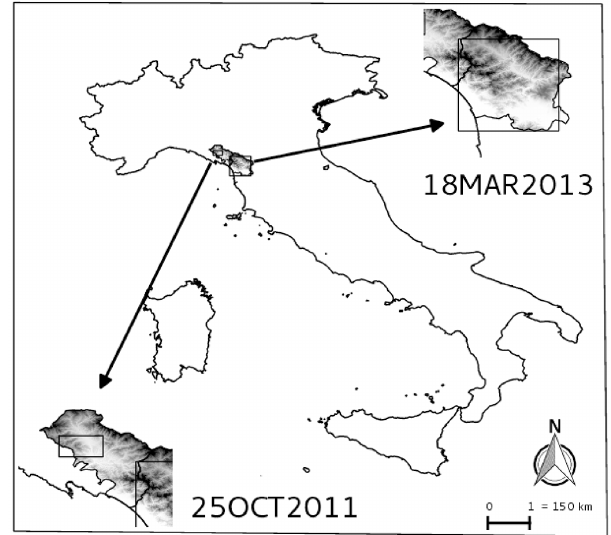
Figure 1. Map of Italian domain showing the two areas of in- terest. The left inset shows the Lunigiana area belonging to the administrative province of Massa-Carrara. This area was affected by the 25OCT2011 event. The right inset shows the Garfagnana area belonging to the administrative province of Lucca. This area was affected by the 18MAR2013 event. Both insets show the area (black rectangles) where the statistical models were implemented and tested. The outer black rectangle represents the domain of the WRF